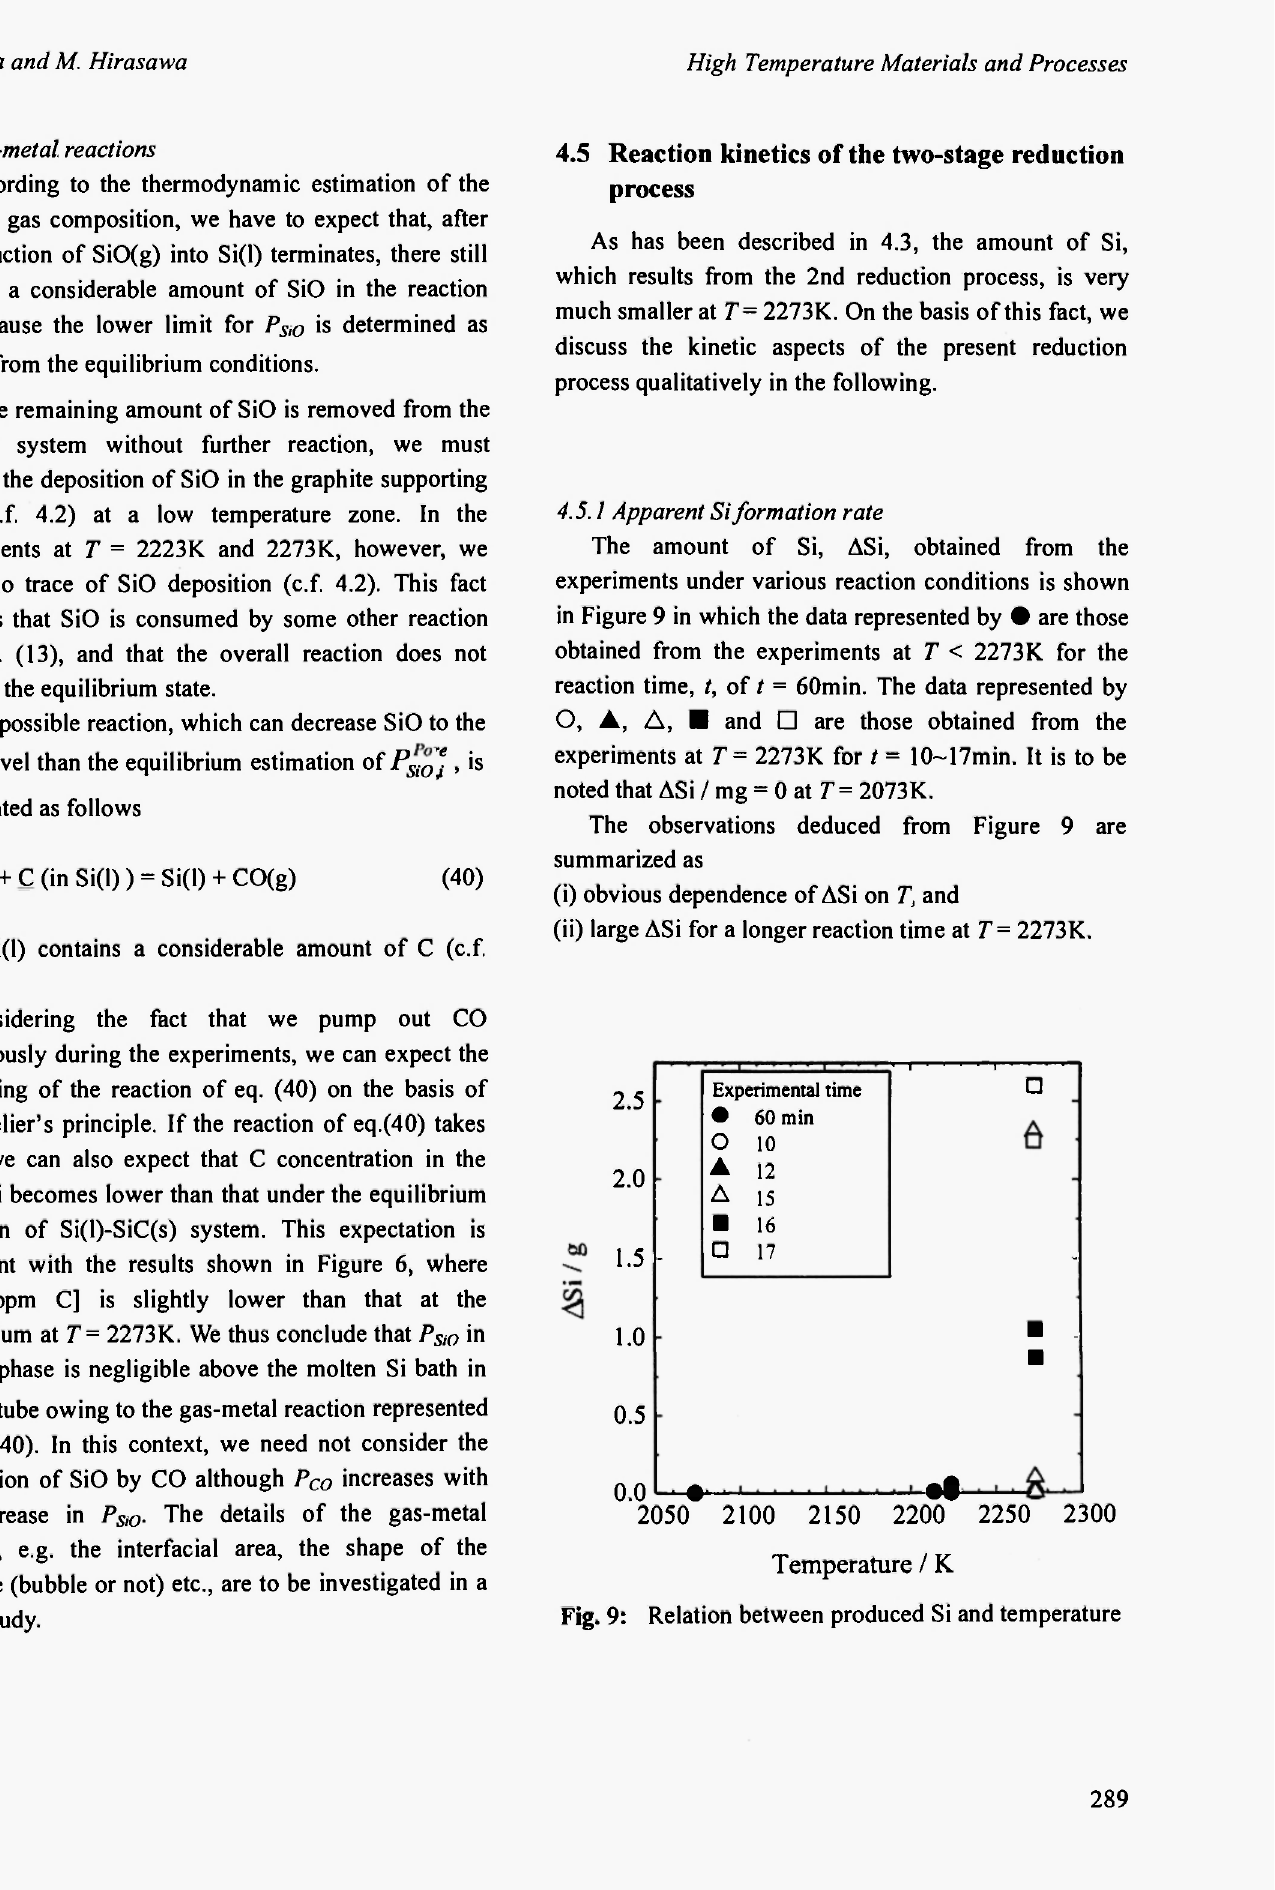
Fig. 9: Relation between produced Si and temperature